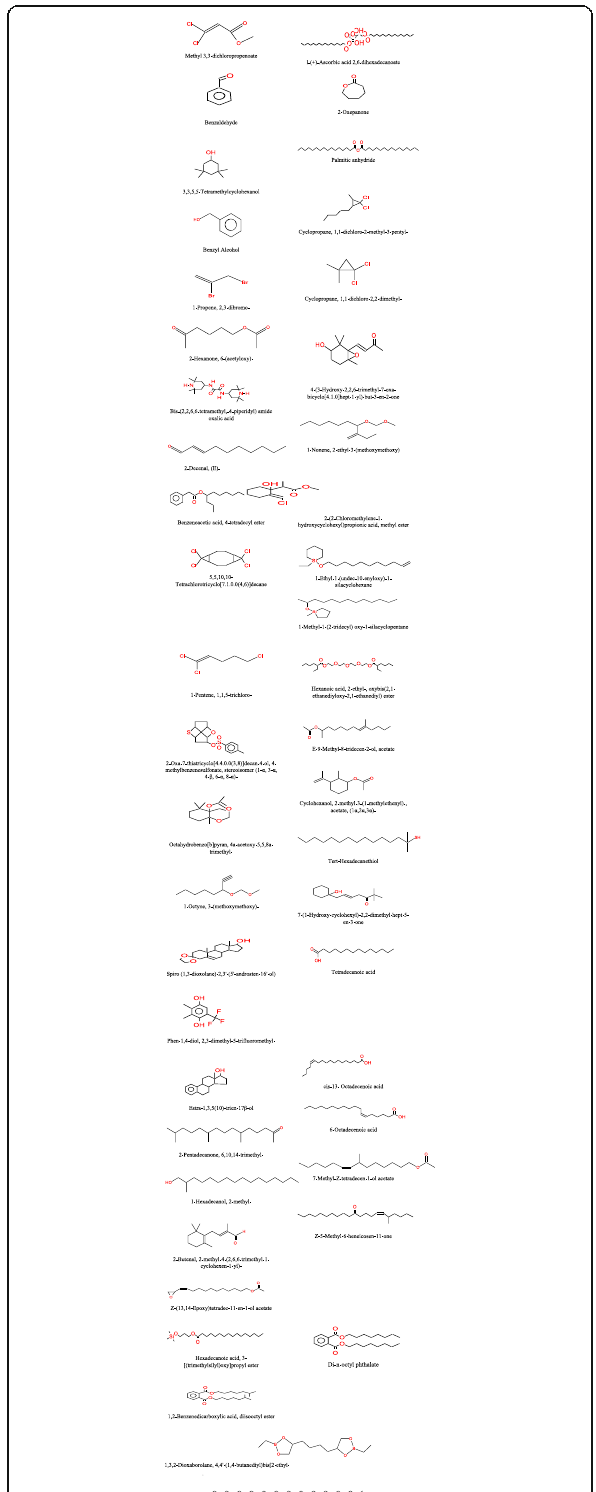
Fig. 3 Compounds identified from n -hexane soluble fraction of Sargassum